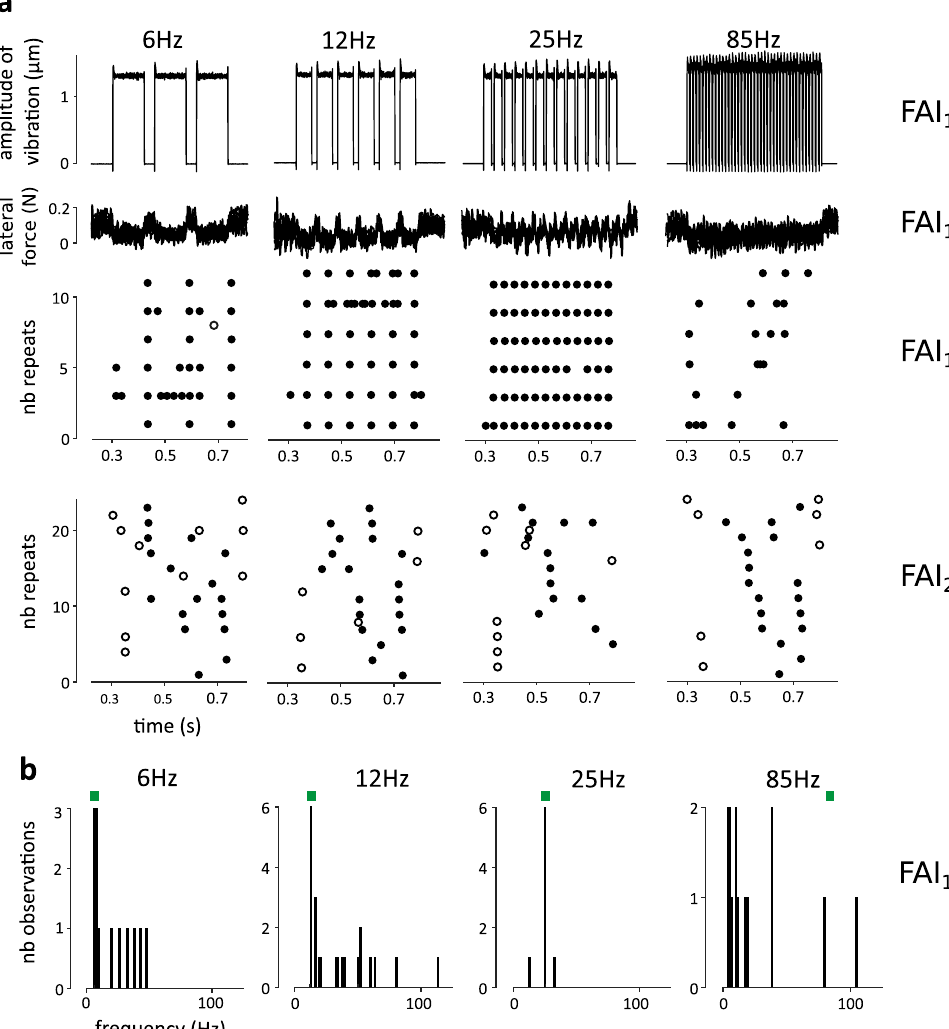
Figure 4. Gratings. ( a ) Profiles of ultrasonic vibration, profiles of lateral force, and the corresponding raster plots are shown for FAI 1 at four distinct frequencies of stimulation: 6, 12, 25 and 85 Hz. Filled/unfilled dots indicate ulnar/radial direction of sliding. Firing followed the frequency of stimulation in a time-locked fashion between 6 to 50 Hz for this unit. Raster plots are also shown for FAI 2 at the same frequencies, where there was no frequency following. ( b ) Histogram of firing frequencies obtained for each condition are shown for FAI 1